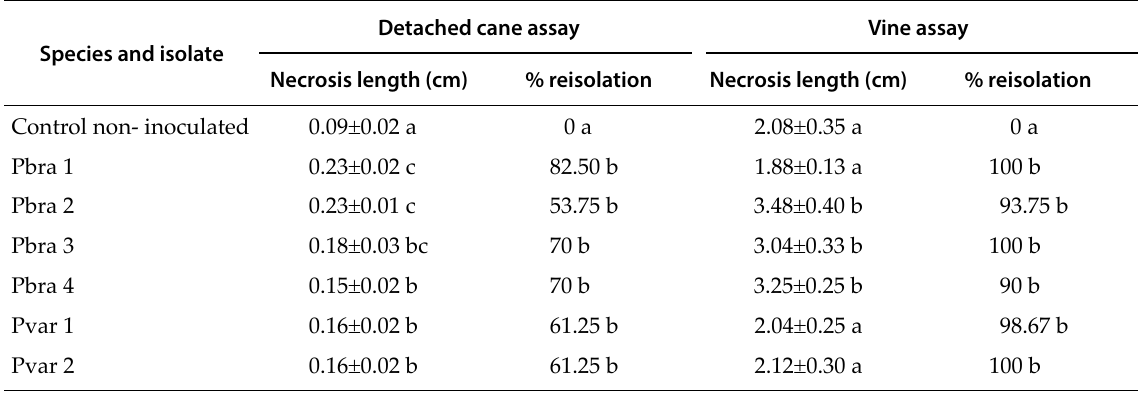
Table 3. Mean necrosis lengths (± standard errors) and mean reisolation proportions for isolates of Paraconiothyrium brasil- iense (Pbra) and P. Variabile (Pvar) recorded in the pathogenicity tests on ‘Tempranillo’ detached canes and standing vines. Statistically significant differences ( P <0.05) between means are shown in different